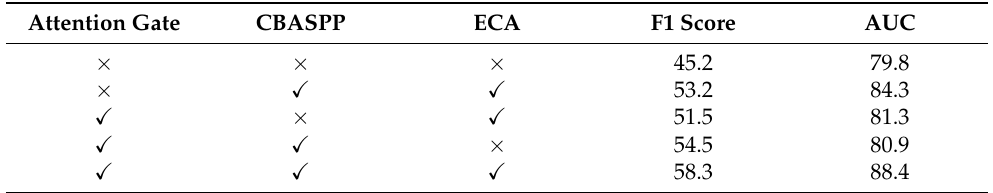
Table 2. Experimental data of ablation study results on CASIA dataset.